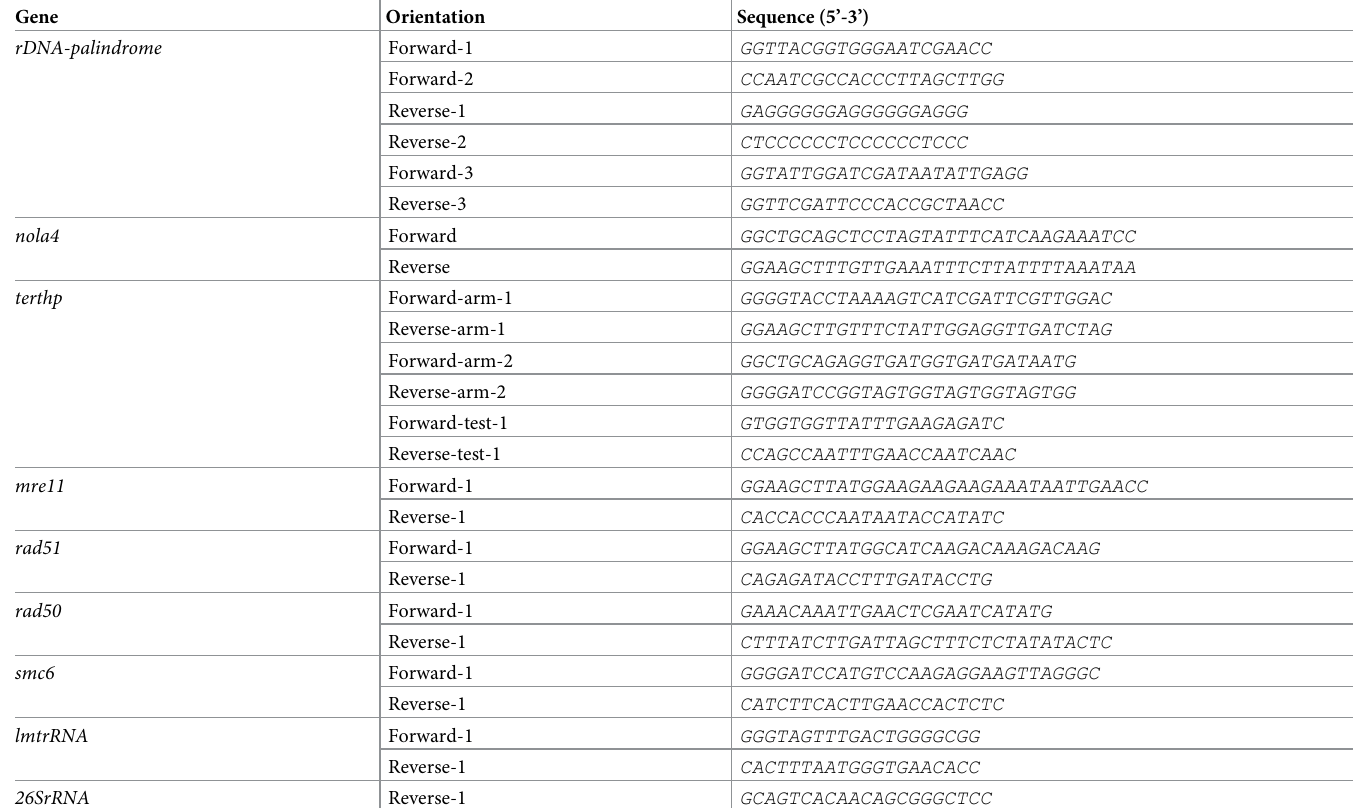
Table 1. Oligonucleotides.